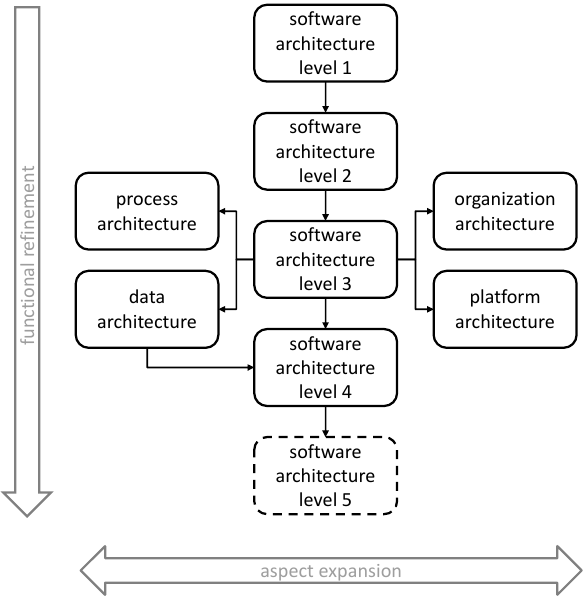
Figure 4. High-level structure of the HORSE architecture [27].